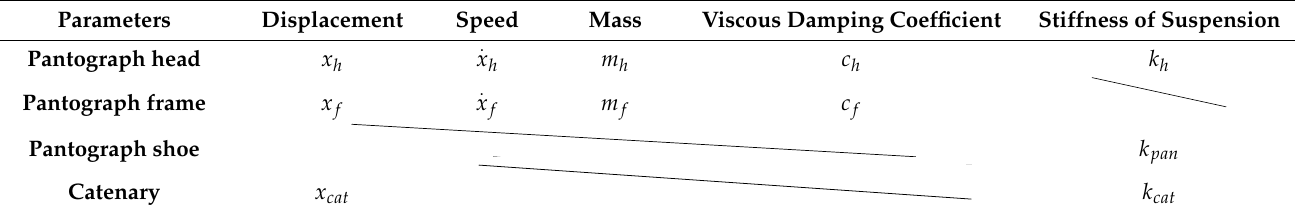
Figure 1. The prototype of a light rail vehicle. ( a ) Pantograph–catenary system components; ( b ) lumped-mass model. Reprinted with permission from ref. [18]. Copyright 2016 IEEE. Table 1. Pantograph–catenary system parameter values.